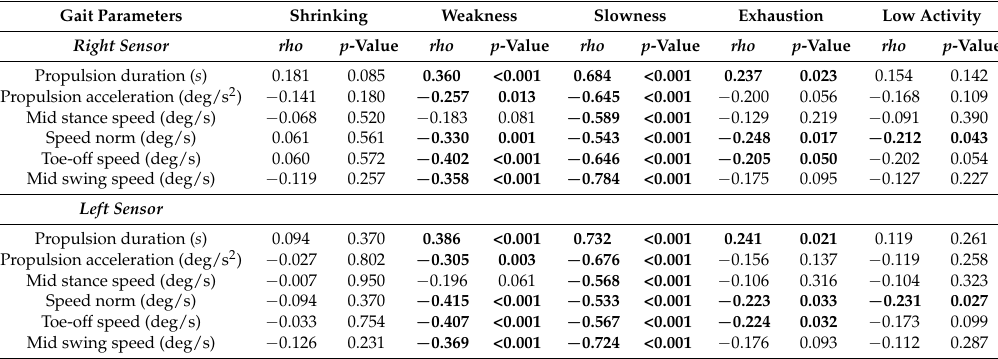
Table 4. Correlations between Fried phenotypes and sensor-derived gait parameters.